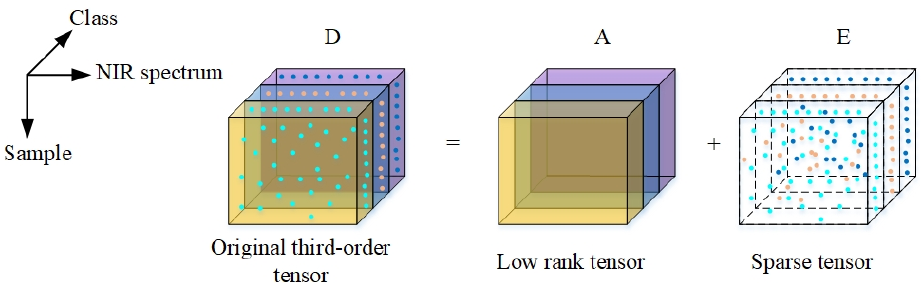
Figure 6. Third-order tensor robust principal component analysis model.